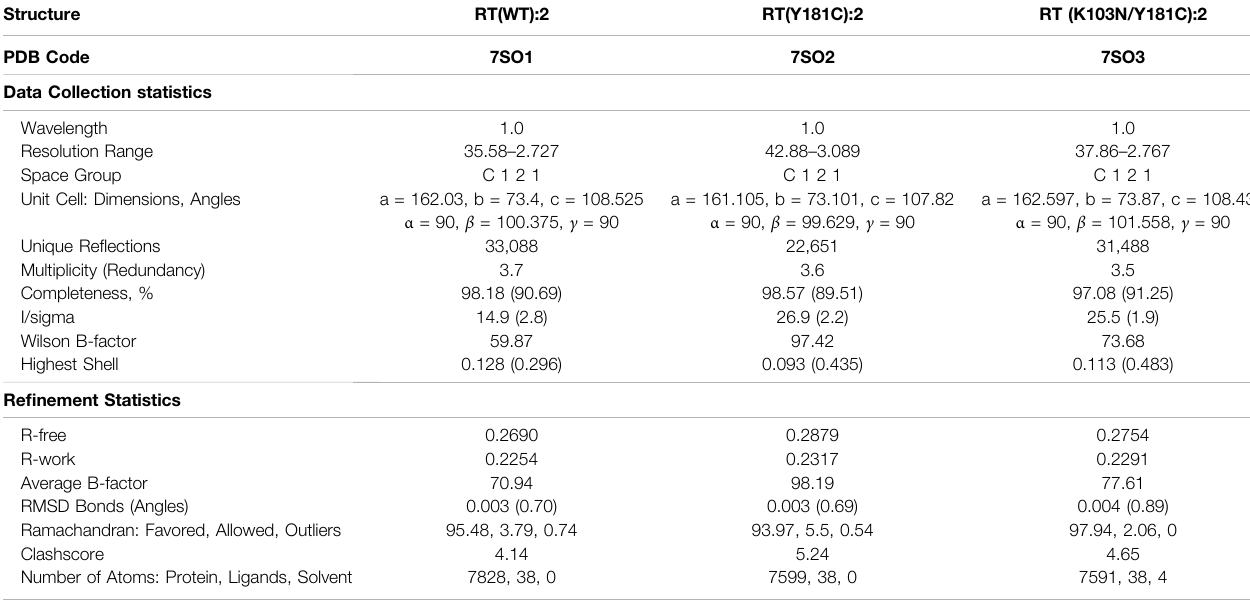
TABLE 2 | Data collection and re fi nement statistics for RT crystal structures in complex with compound 2 . Structure